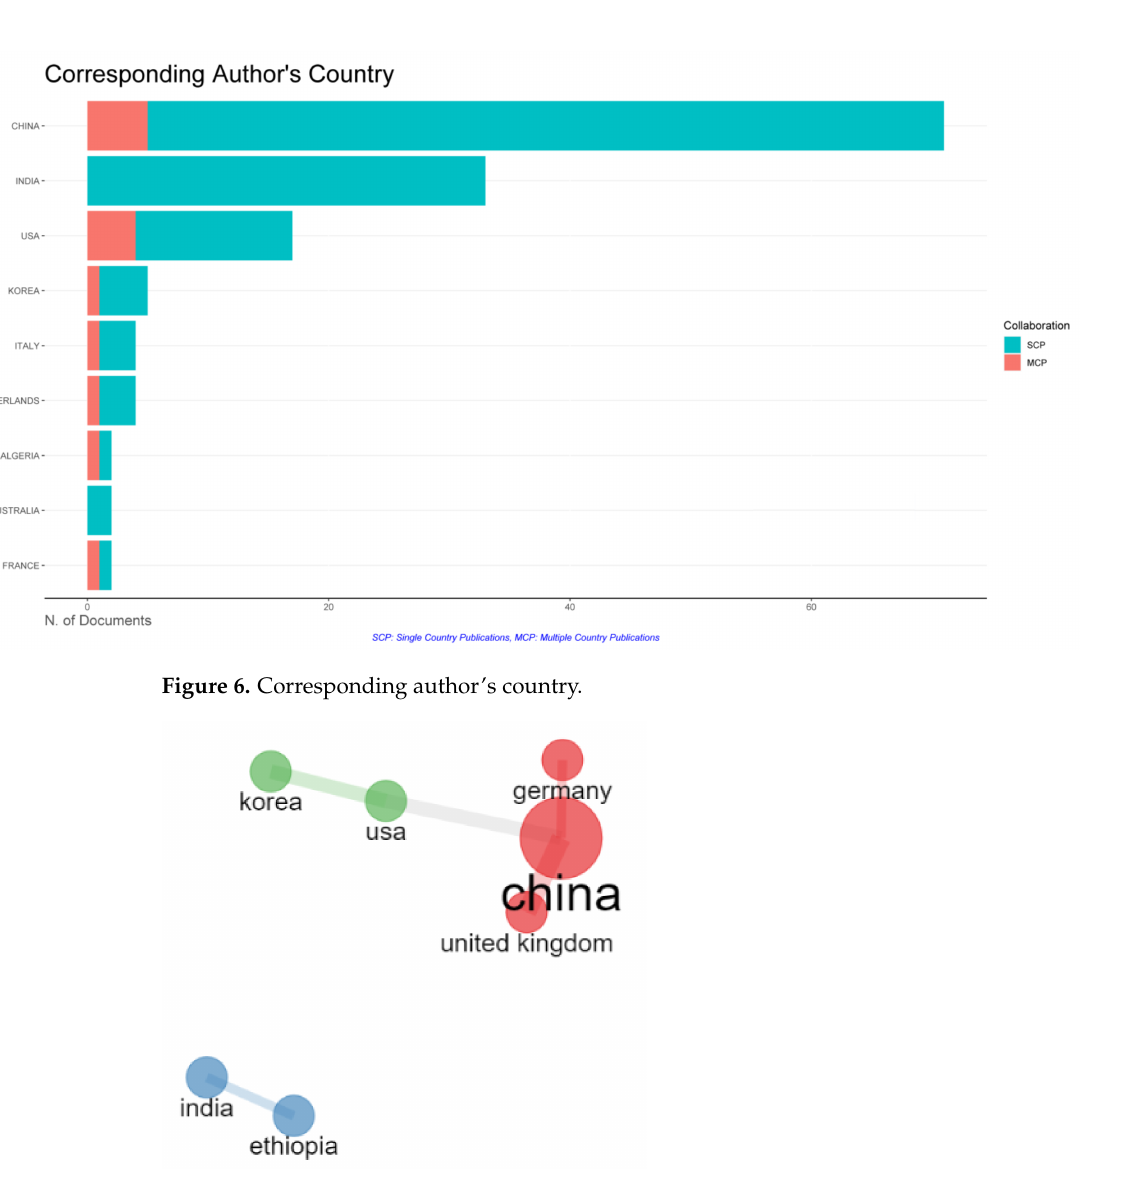
Figure 7. Collaboration